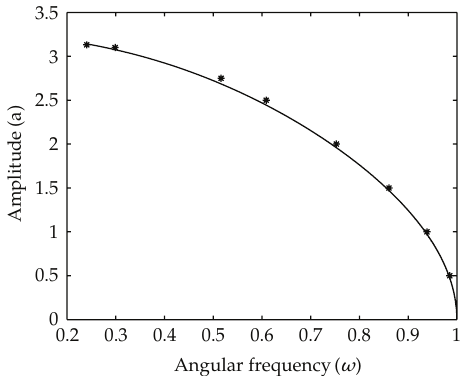
Figure 2: The diagram of amplitude A depending on frequency ω for